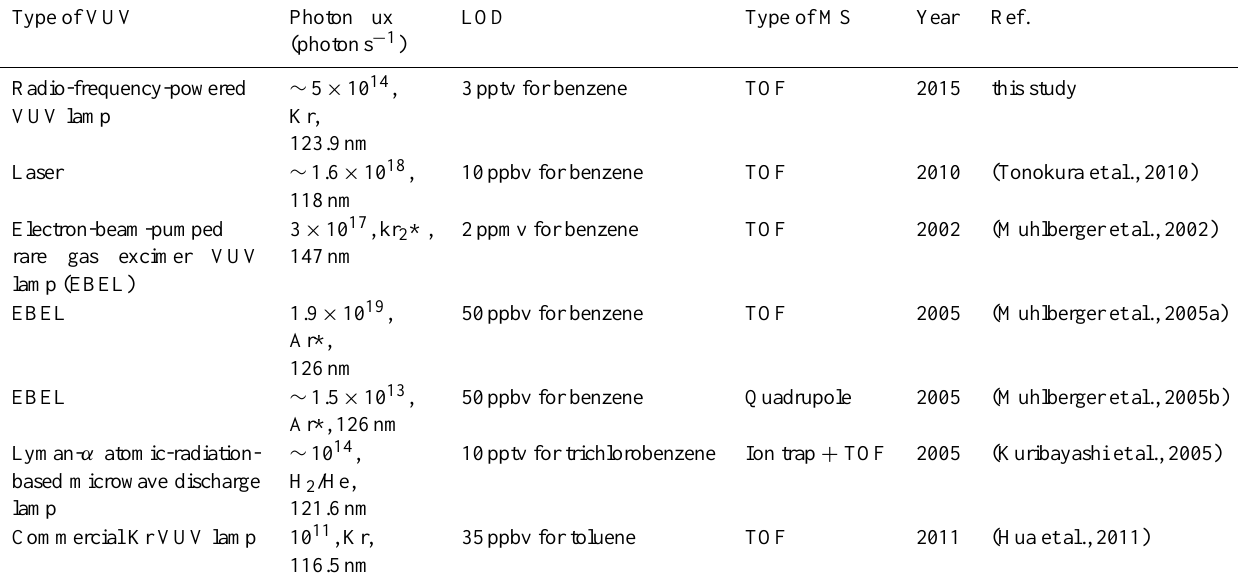
Table 1. Performance of instruments using different light sources. Type of